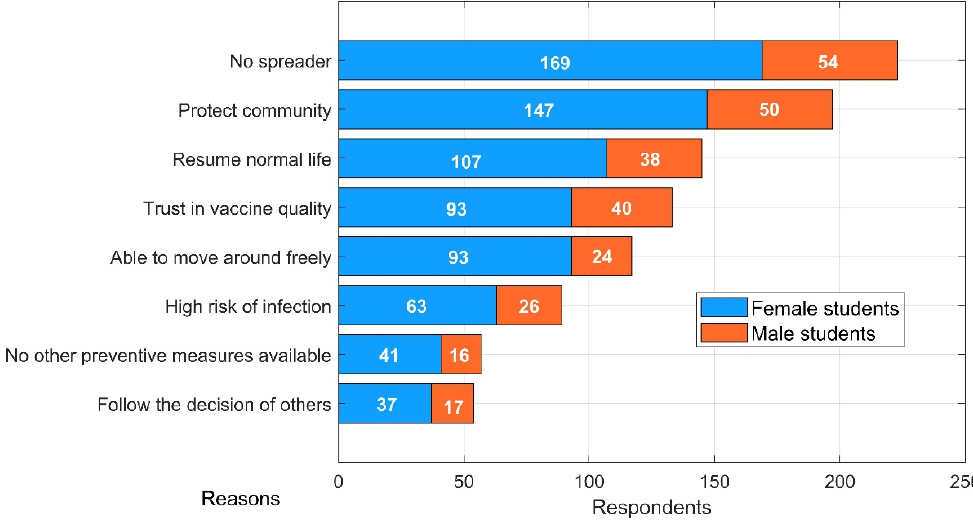
Figure 4. Reasons for getting vaccinated.